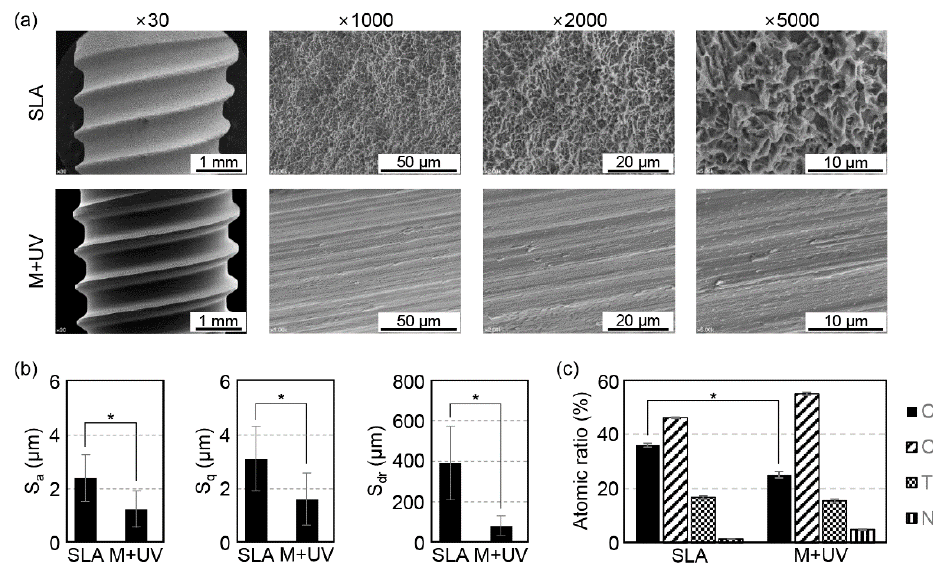
Figure 3. ( a ) Scanning electron microscopy (SEM) images of the Ti implants. SLA: Sandblasted with large grit and acid etched surface (top row); M + UV: Machined surface treated with ultraviolet light (bottom row). Magnification: × 30, × 1000, × 2000, and × 5000 from the left. ( b ) Surface roughness (Sa and Sq) and surface area ratio (Sdr) of the Ti discs according to the confocal laser scanning microscopy (CLSM) analysis. The values of the M + UV surfaces are smaller than the SLA, which means it is smoother than the SLA. ( c ) Element content of the surfaces of the Ti discs according to the energy dispersive x-ray spectrometer (XPS). The M + UV discs contain half of the carbon percentage of the SLA discs. Error bars show the standard deviation. (*) represents the significance compared with each pair, p < 0.05.